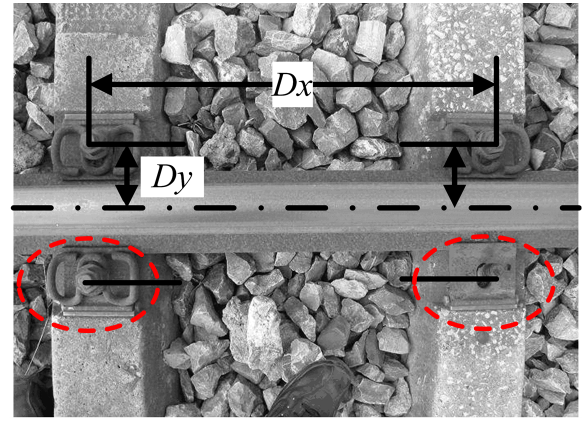
Figure 1. Sample image of